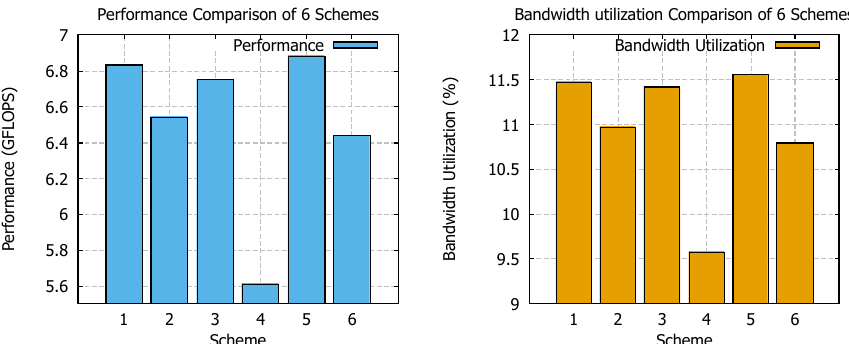
Figure 8. Six scheme performance and bandwidth utilization